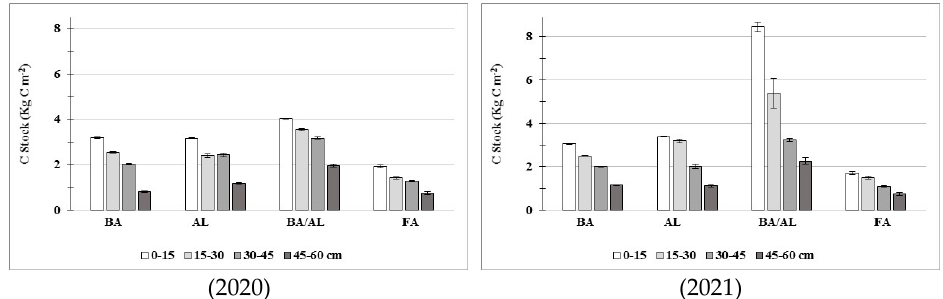
Figure 7. Evolution in organic carbon stocks in 2020 and 2021 under the different vegetations. Figure 6. Evolution in organic carbon stocks in 2020 and 2021 under the different